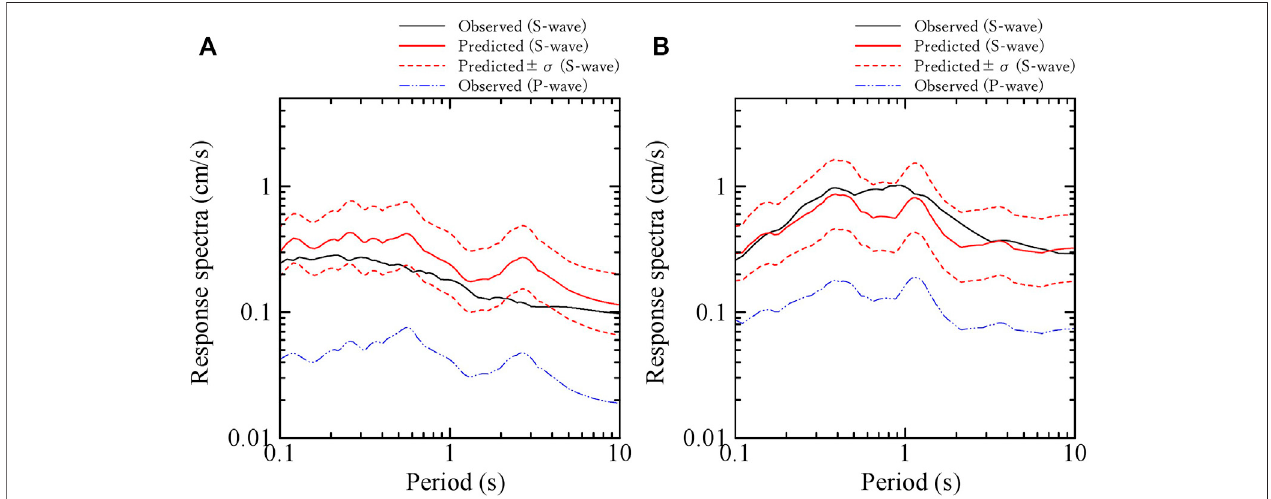
FIGURE 9 | Predicted pseudo-velocity response spectra (a damping coef fi cient of 20%) of S-wave for the earthquake of Mj 5.9 on 11th/April 2011 at KS and SS stations whose accelerations are shown in Figure 3 , with the average ± the standard deviation. Observed pseudo-velocity response spectra of P-wave for the earthquake are also shown. (A) KS station (B) SS station.